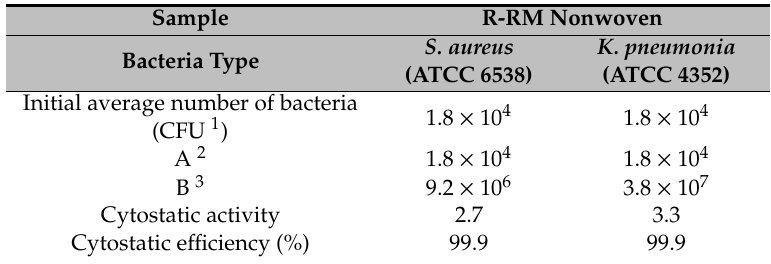
Table 5. Antibacterial ability of the R-RM nonwoven dyed with T. chebula dye according to bacteria strains.